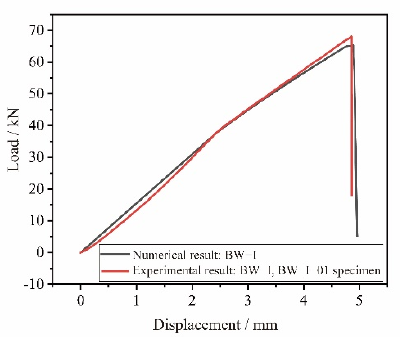
Figure 26. Comparison of the experimental and numerical strain-load curves for the composite beam of BW-I.